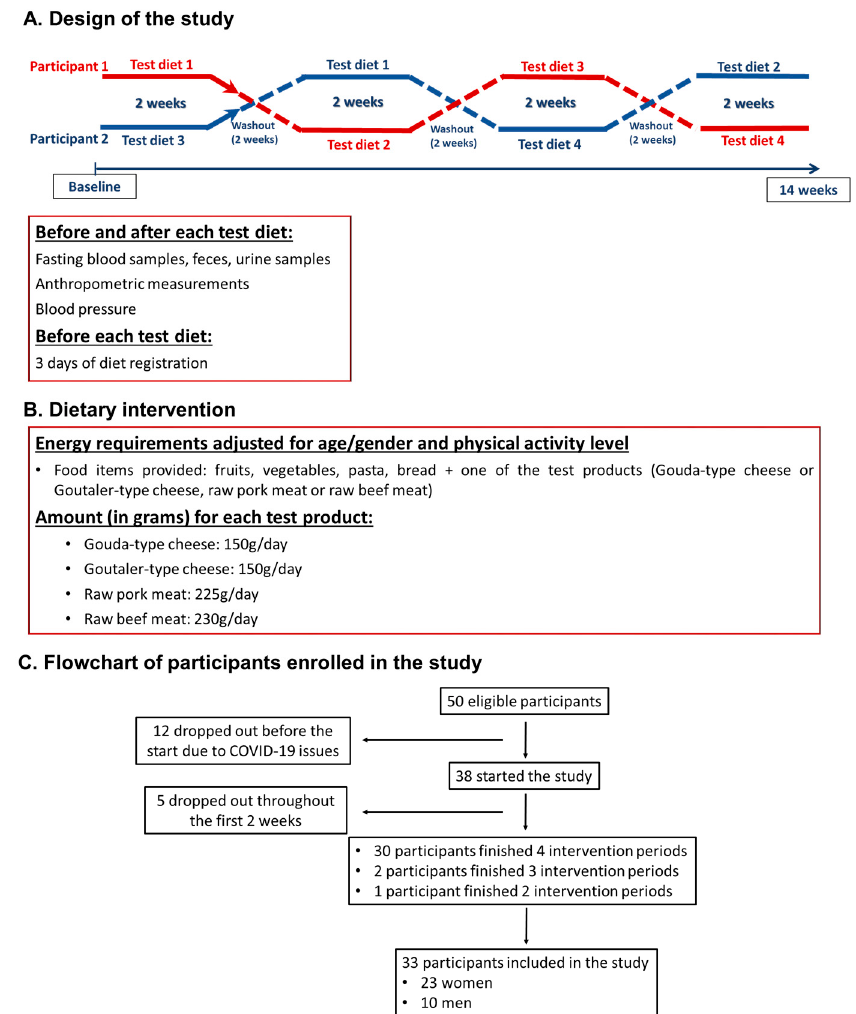
Figure 6. Design of the study ( A ), dietary intervention protocol ( B ), and flowchart of participants enrolled in the study ( C ).